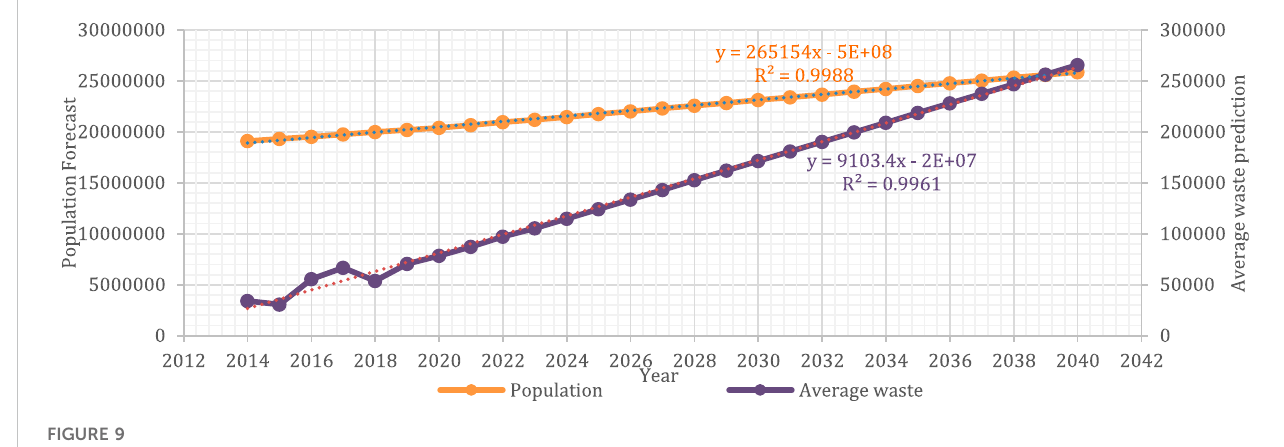
FIGURE 9 Prediction of beach waste based on population forecast and regression equation from Figure